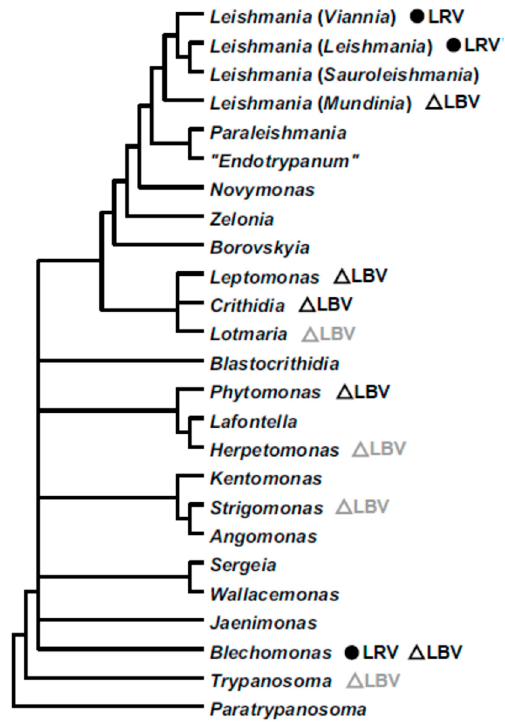
Figure 5. A schematic phylogenetic tree of the family Trypanosomatidae (modified from [13]), demonstrating the distribution of leishbunyaviruses (triangles) and leishmaniaviruses (circles) over the genera of these flagellates. Viruses identified in metatranscriptomes of trypanosomatid-infected insects [38] are shown in grey.